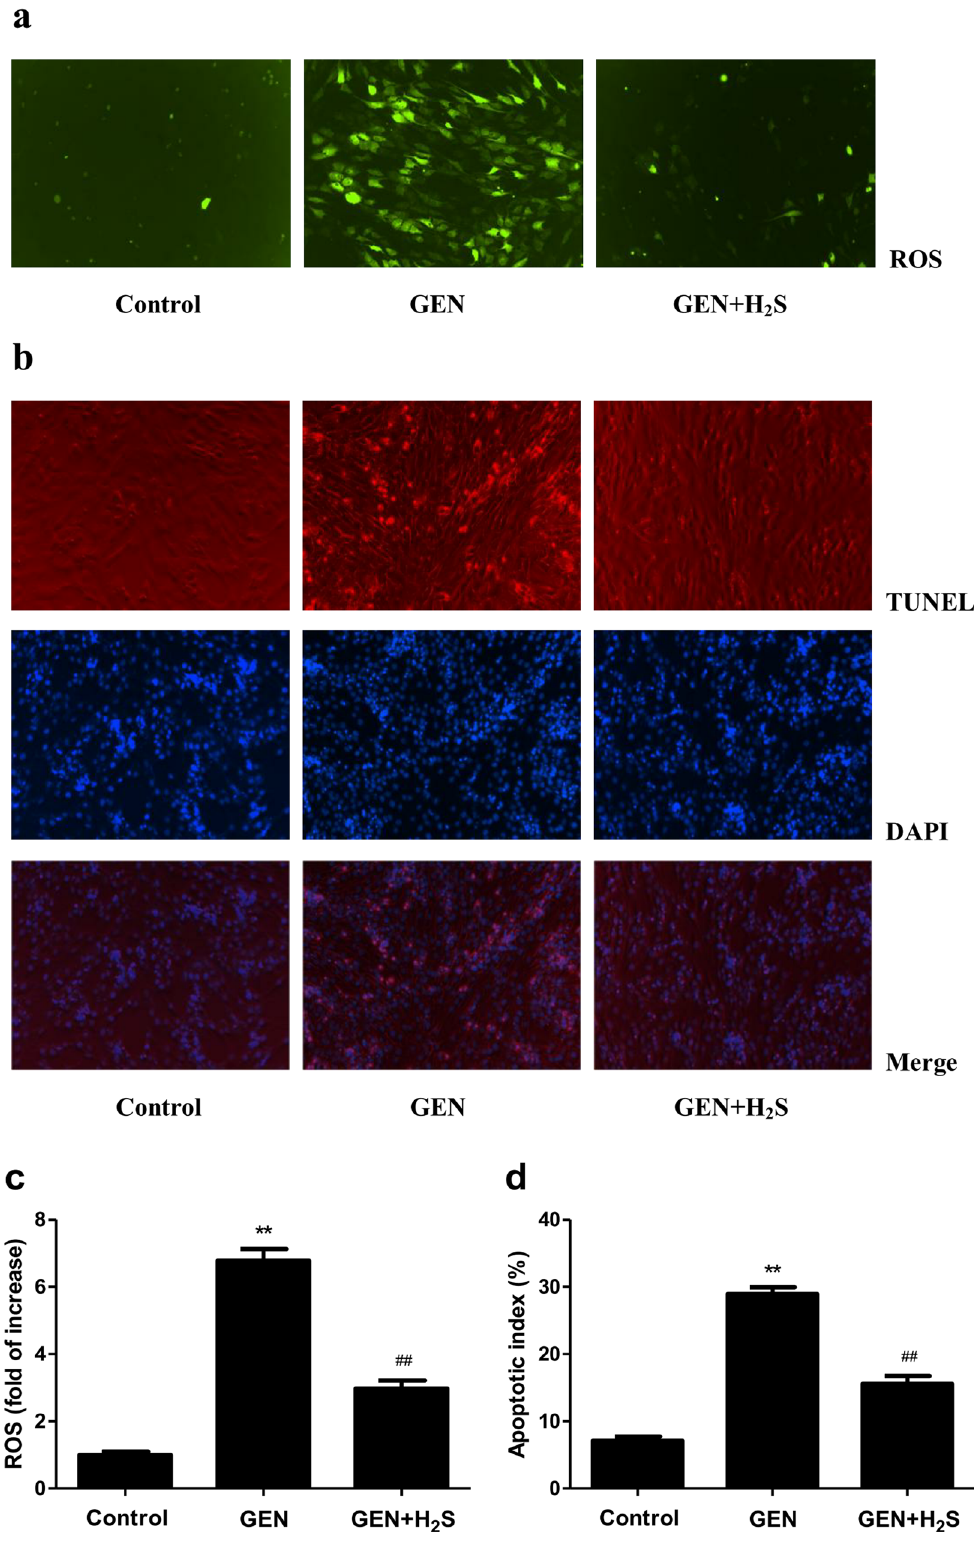
Figure 2. Effects of H 2 S on the intracellular ROS production and apoptosis in GEN-treated NRK-52E cells. ( a ) The intracellular ROS production was detected using the fluorescent probe DCF-DA (shown in green; original magnification, × 100). ( b ) The cell apoptosis was determined by TUNEL assay. Apoptotic cell nuclei were stained by TUNEL assay with red, and all nuclei were stained by DAPI with blue (original magnification, × 100). ( c ) The intracellular ROS production was measured. ( d ) The apoptotic index was calculated. Values were presented as mean ± SEM (n = 6); * P < 0.05, ** P < 0.01 compared with the control group; # P < 0.05, ## P < 0.01 compared with the GEN